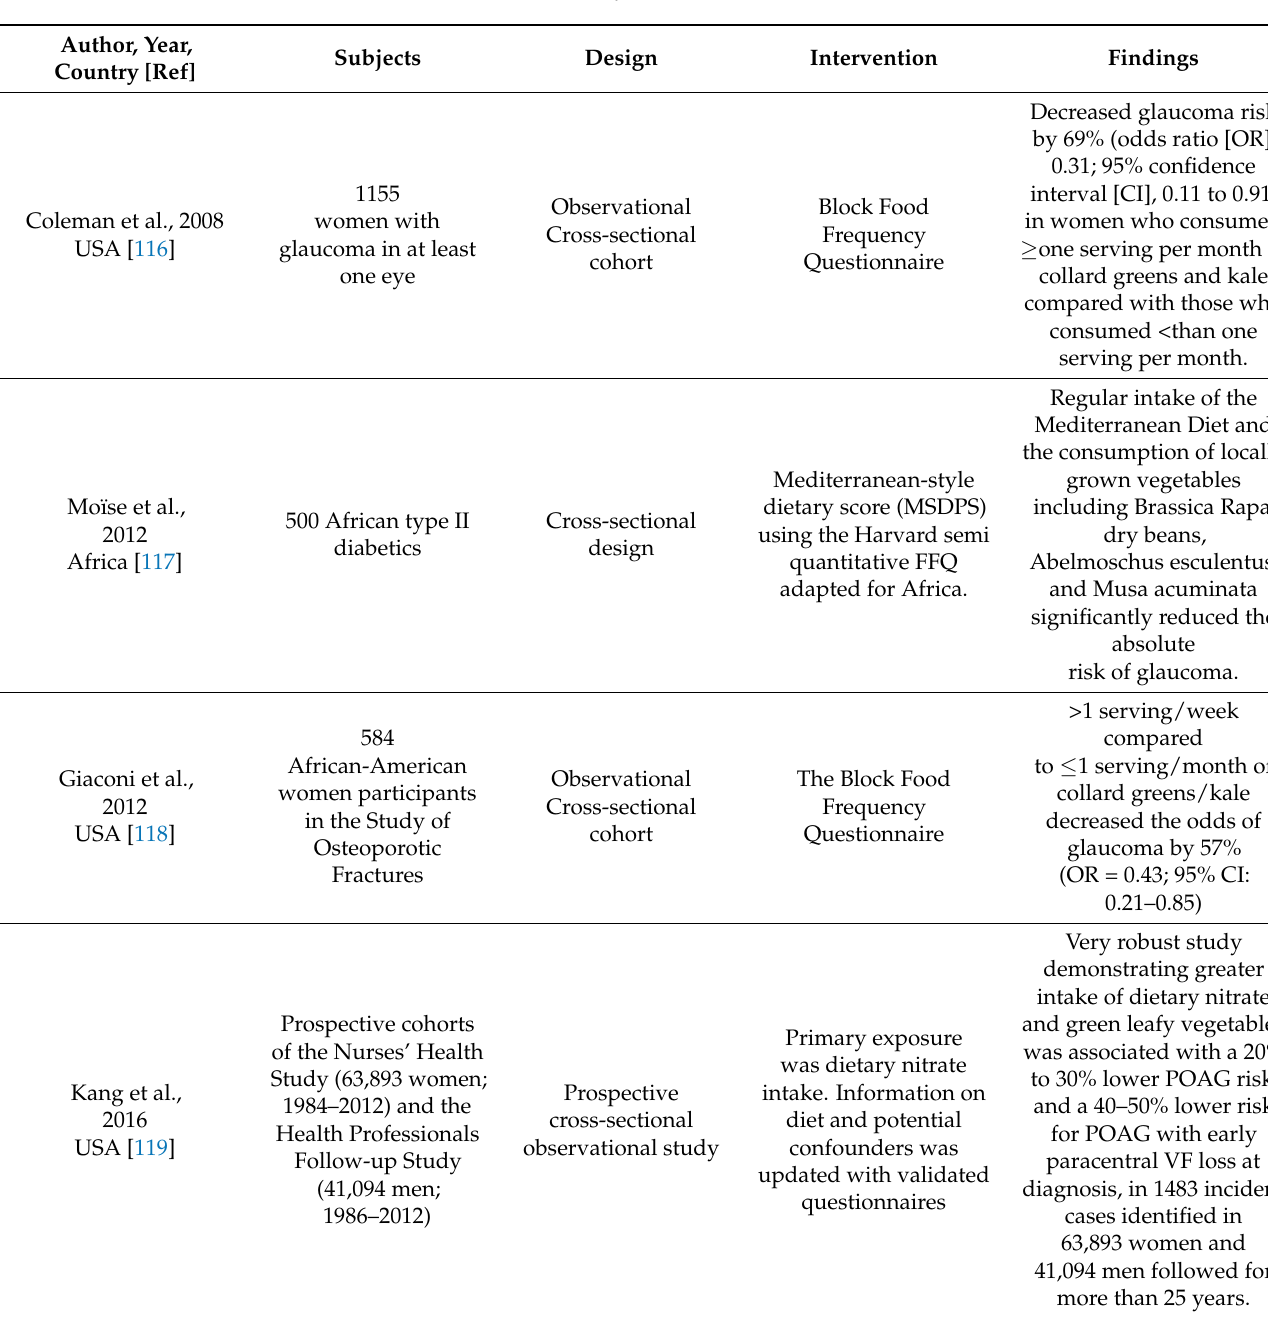
Table 4. Glaucoma and dietary intake